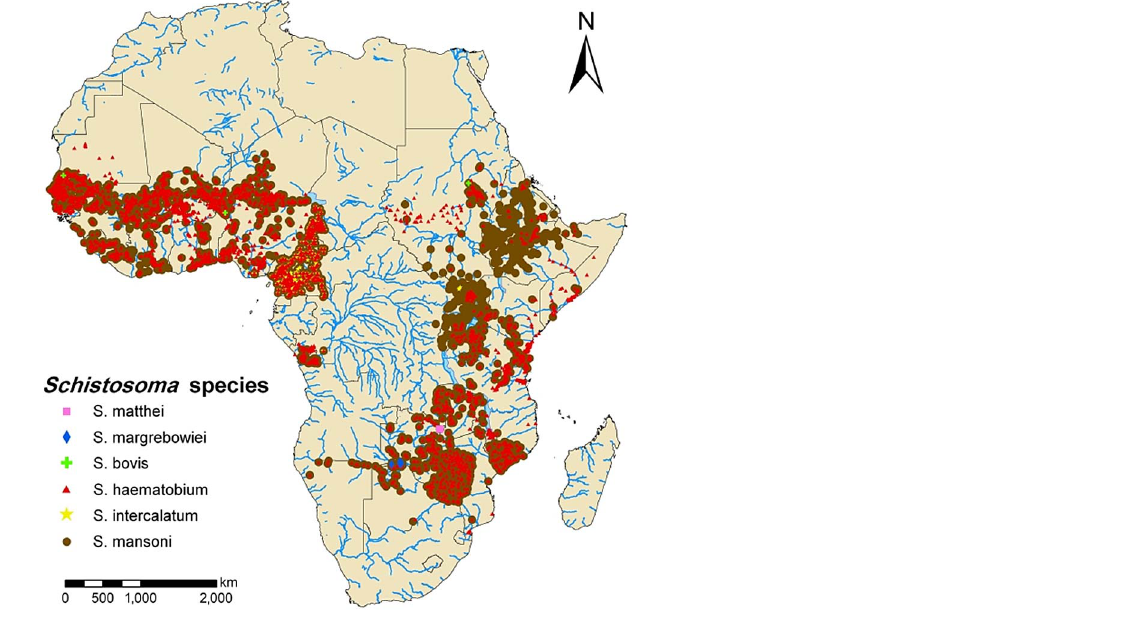
Figure 2. Distribution of African schistosomiasis survey locations published by Hu¨rlimann etal. in PLOSNeglectedTropicalDiseases in 2011 [ 18 ] .